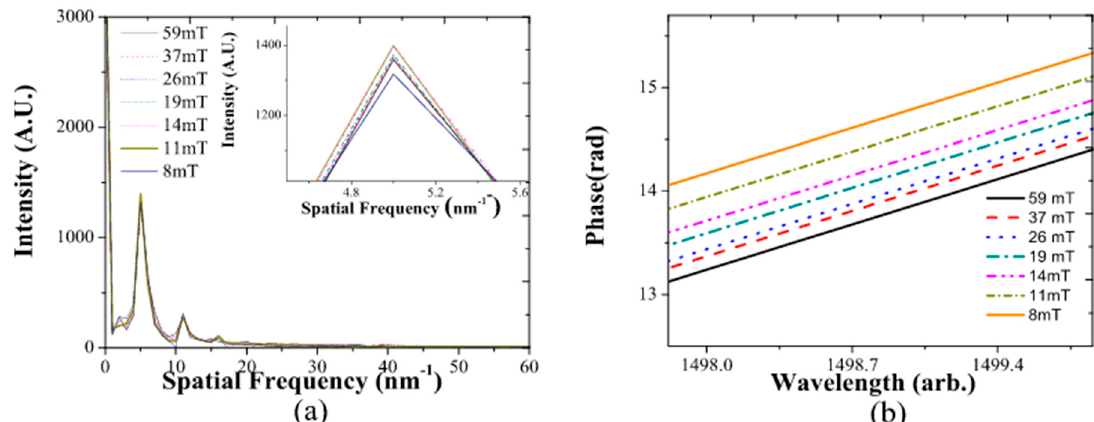
Figure 6. ( a ) Spatial frequency spectrum for BTOF 1 when the magnetic field was applied; ( b ) phase changes of the filtered BTOF 1 Fourier component when the magnetic field increased.